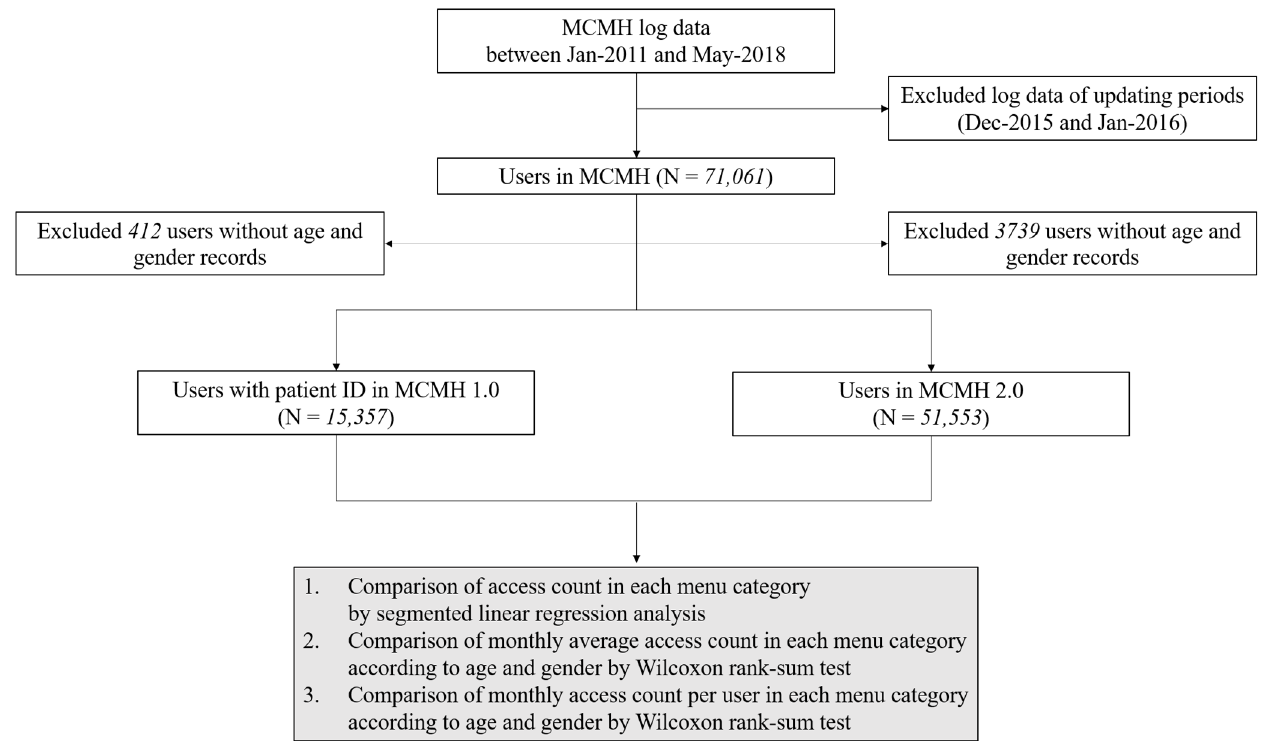
Figure 2. Study flow diagram. MCMH: My Chart in My Hand, ID: